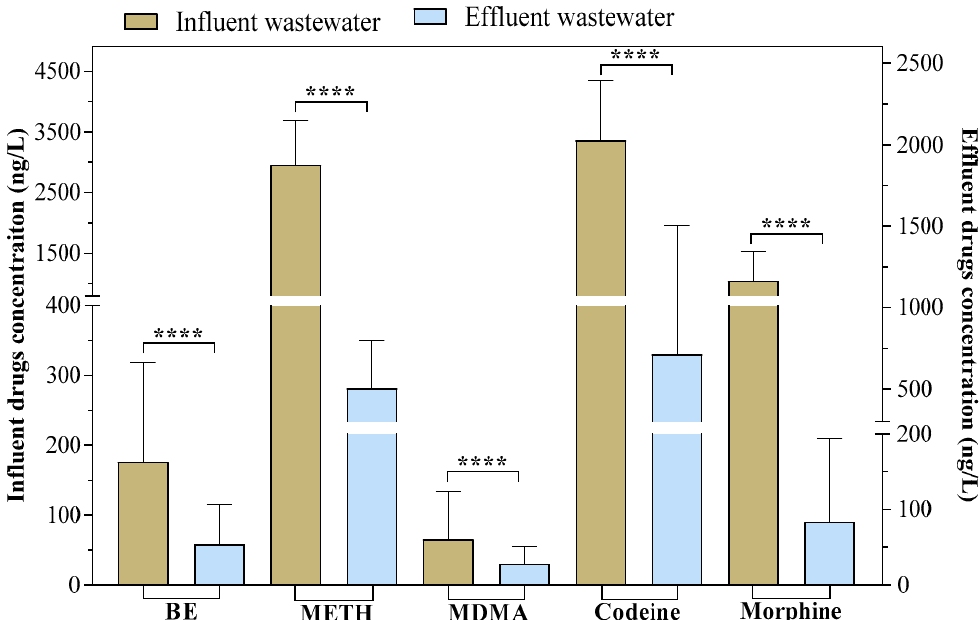
Figure 4. Targeted drugs average concentration profiles in influent and effluent wastewater samples collected from each WWTP during the study period. The concentrations are presented as mean ± SD where n = 112 for influent and n = 140 for effluent samples. Asterisks represent statistically significant differences between influent and effluent concentrations (significance level of 2-tailed t -test where: **** = p < 0.001).